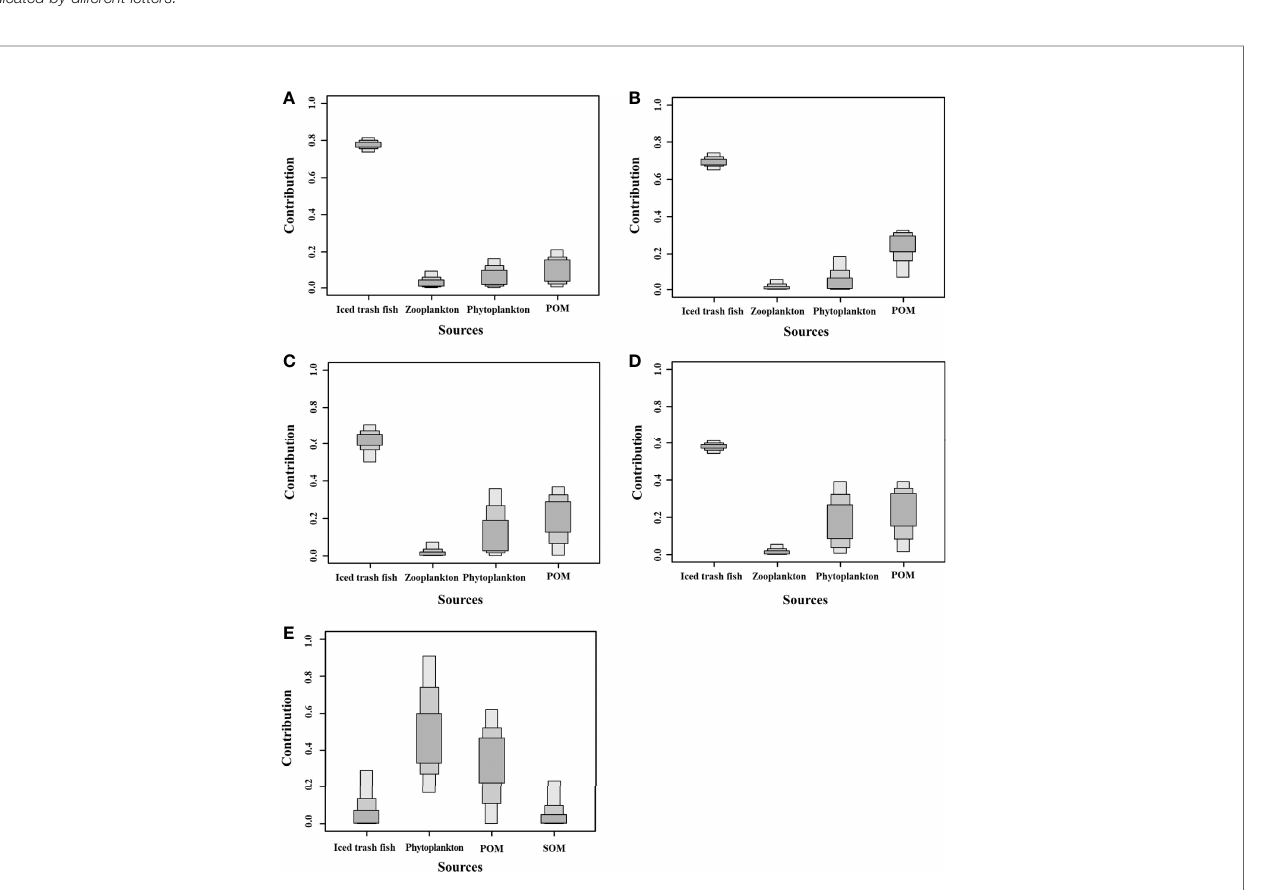
FIGURE 4 | Contributions of different food sources to cultured organisms. (A) Contributions of different food sources to P. trituberculatus in the PM system; (B) Contributions of different food sources to M. japonicus in the PM system; (C) Contributions of different food sources to P. trituberculatus in the PMS system; (D) Contributions of different food sources to M. japonicus in the PMS system; (E) Contributions of different food sources to S. constricta in the PMS